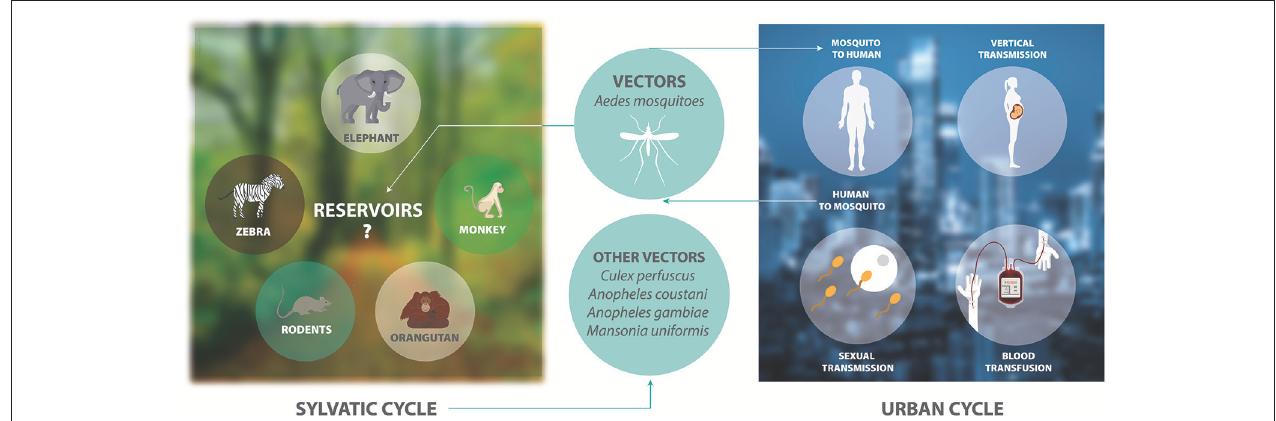
FIGURE 1 | The transmission cycle of ZIKV. The sylvatic cycle involves the maintenance of ZIKV between non-human primates and arboreal mosquitoes in forests. There is only serological evidence showing that elephants, zebras, rodents, and orangutans are possible reservoirs of ZIKV. The urban cycle involves the transmission of ZIKV between humans and mosquitoes in urban